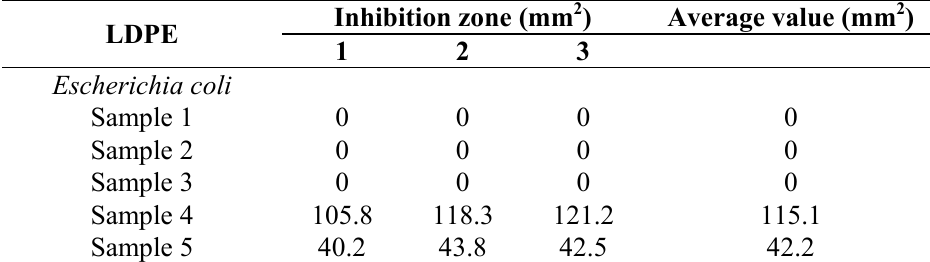
Table3. Inhibition zone area